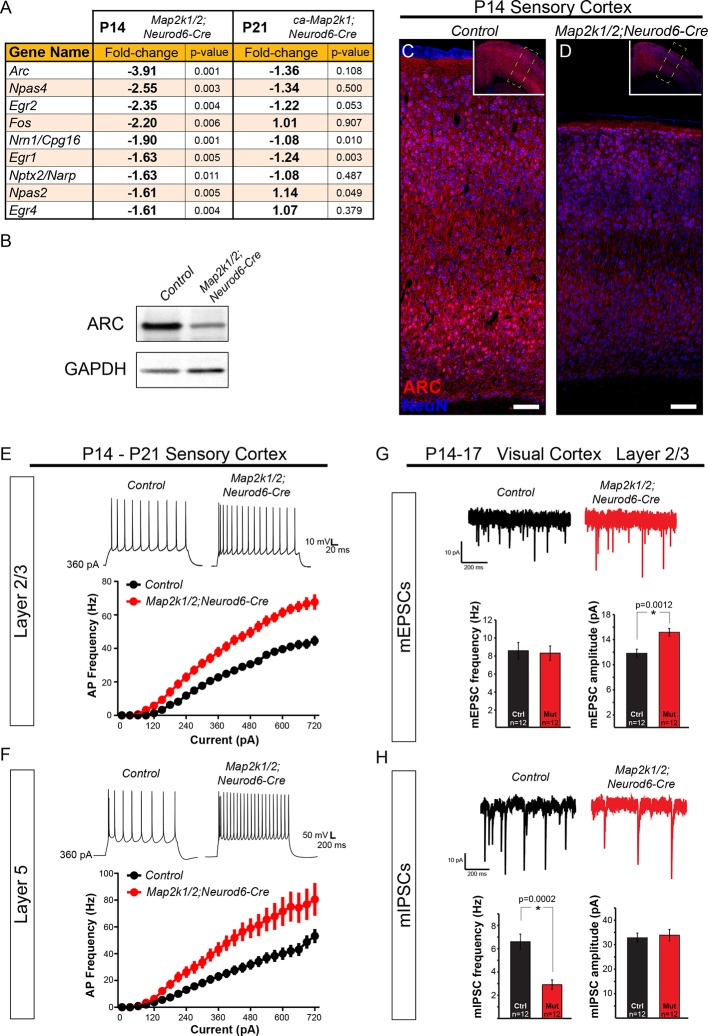
ERK/MAPK signaling promotes ARC expression and reduces neuron excitability in layer 2/3 and 5 pyramidal neurons during development.(A) Microarray profiling of whole cortical lysates detected a significant decrease in the expression of activity-dependent genes in P14 Map2k1/2;Neurod6-Cre mice compared to controls (n=3). (B) Western blotting of P14 control and Map2k1/2;Neurod6-Cre whole cortical lysates confirmed the decrease in ARC expression in mutant cortices (B) (n=3). (C-D) Immunostaining with an ARC antibody shows reduced expression across all cortical layers in P14 Map2k1/2;Neurod6-Cre mutants (D) when compared to controls (C) (n=3, scale bar=100 µm). (E–F) Average action potential frequency-current (F/I) curves recorded from layer 2/3 (E) and layer 5 (F) pyramidal neurons in acute slices of control and Map2k1/2;Neurod6-Cre sensory cortices. Recordings were performed in the presence of DNQX, APV, and picrotoxin to block all synaptic activity. Both layer 5 (n=16 control, 14 mutant neurons, mean ± SEM; F/I Slope t-test, p<0.0001) and layer 2/3 (n=14 control, 14 mutant neurons, mean ± SEM; F/I Slope t-test, p<0.0001) pyramidal neurons in Map2k1/2;Neurod6-Cre sensory cortices exhibited a marked increase in action potential firing frequency in response to increasing current injections. (G–H) Recordings of miniature excitatory postsynaptic currents in layer 2/3 pyramidal neurons from the visual cortex revealed a significant increase in the amplitude, but not frequency, of mEPSCs in neurons lacking Map2k1/2 (n=12 neurons of each genotype from three independent litters, mean ± SEM, t-test, p=0.0012) (G). In contrast, a substantial decrease in the frequency, but not amplitude, of mIPSCs from Map2k1/2;Neurod6-Cre neurons was observed (H) (n=12 neurons of each genotype, mean ± SEM, t-test, p=0.0002).